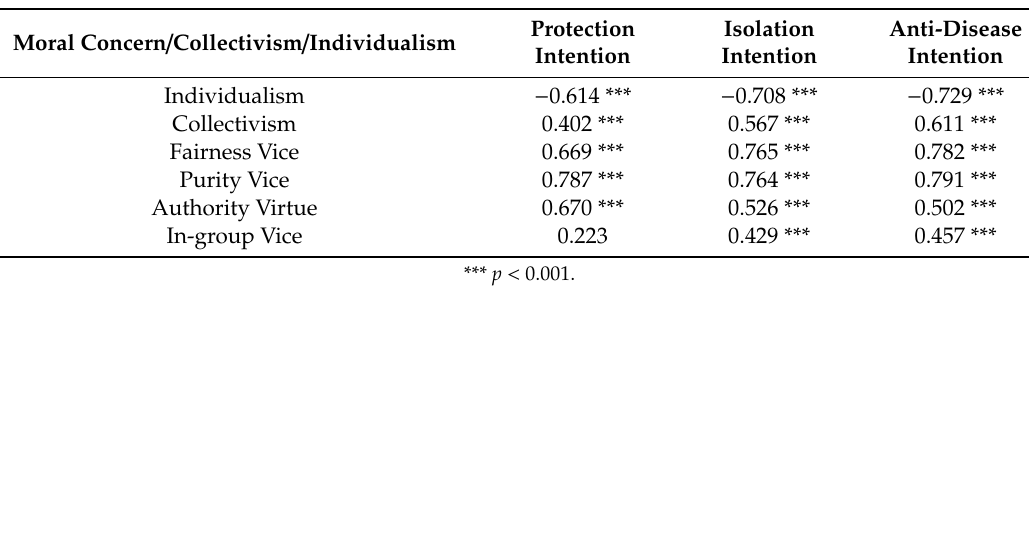
Table 10. Correlation coe ffi cients between moral concern / cultural values and behavioral